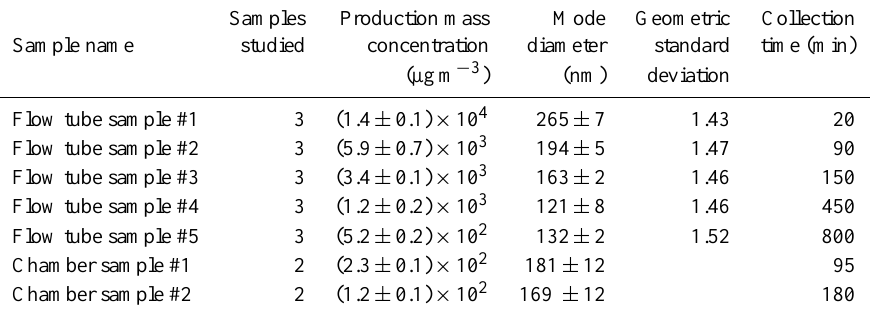
Table 1. Conditions used for generating and collecting samples of SOM generated via the ozonolysis of α -pinene. The whole SOM (both water soluble and water insoluble component of the SOM) was